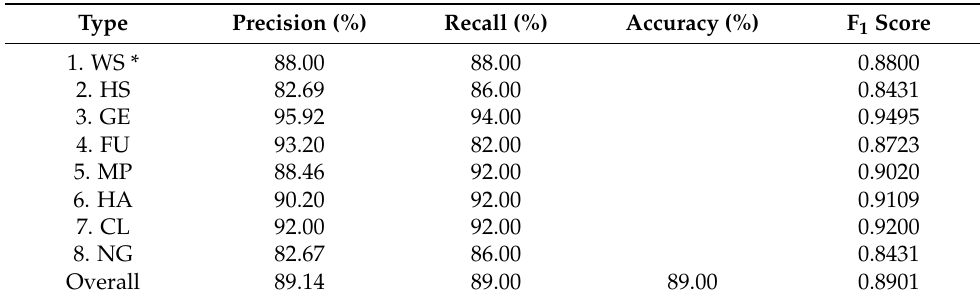
Table 10. Assessment metrics of the eight types of geothermal surface manifestations for the GoogLeNet model on the testing